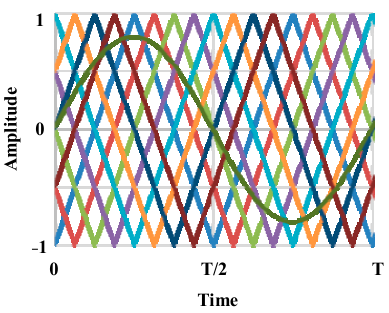
Figure 11. Illustration of the carrier and modulation waveforms for the phase-shift carrier tech- nique.